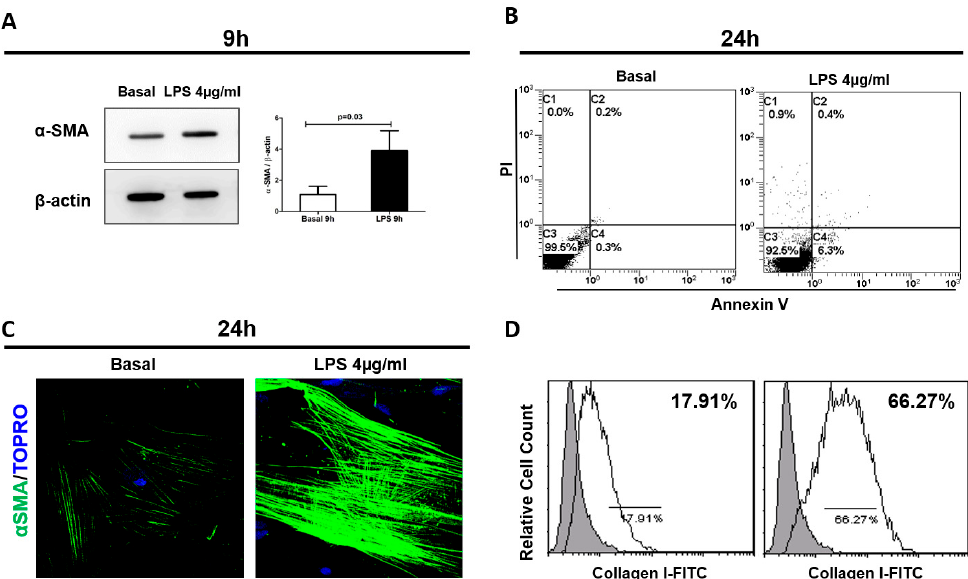
Figure 2. LPS mediated early PMT. Cultured pericytes were incubated with LPS 4 µ g / mL, for 9 and 24 h. ( A ) WB analysis revealed a significant increase of α -SMA expression after 9 h of LPS stimulation, compared to basal level. β -actin protein expression was used for normalization. Data are expressed as mean ± standard deviation (SD) of three independent experiments and compared with the Student t test. 24 h of LPS exposure did not affect pericyte viability ( B ) and induced a remodeling of contractile α -SMA-stress fibers ( C ) and a protein increase of Collagen I ( D ). Results are representative of three independent